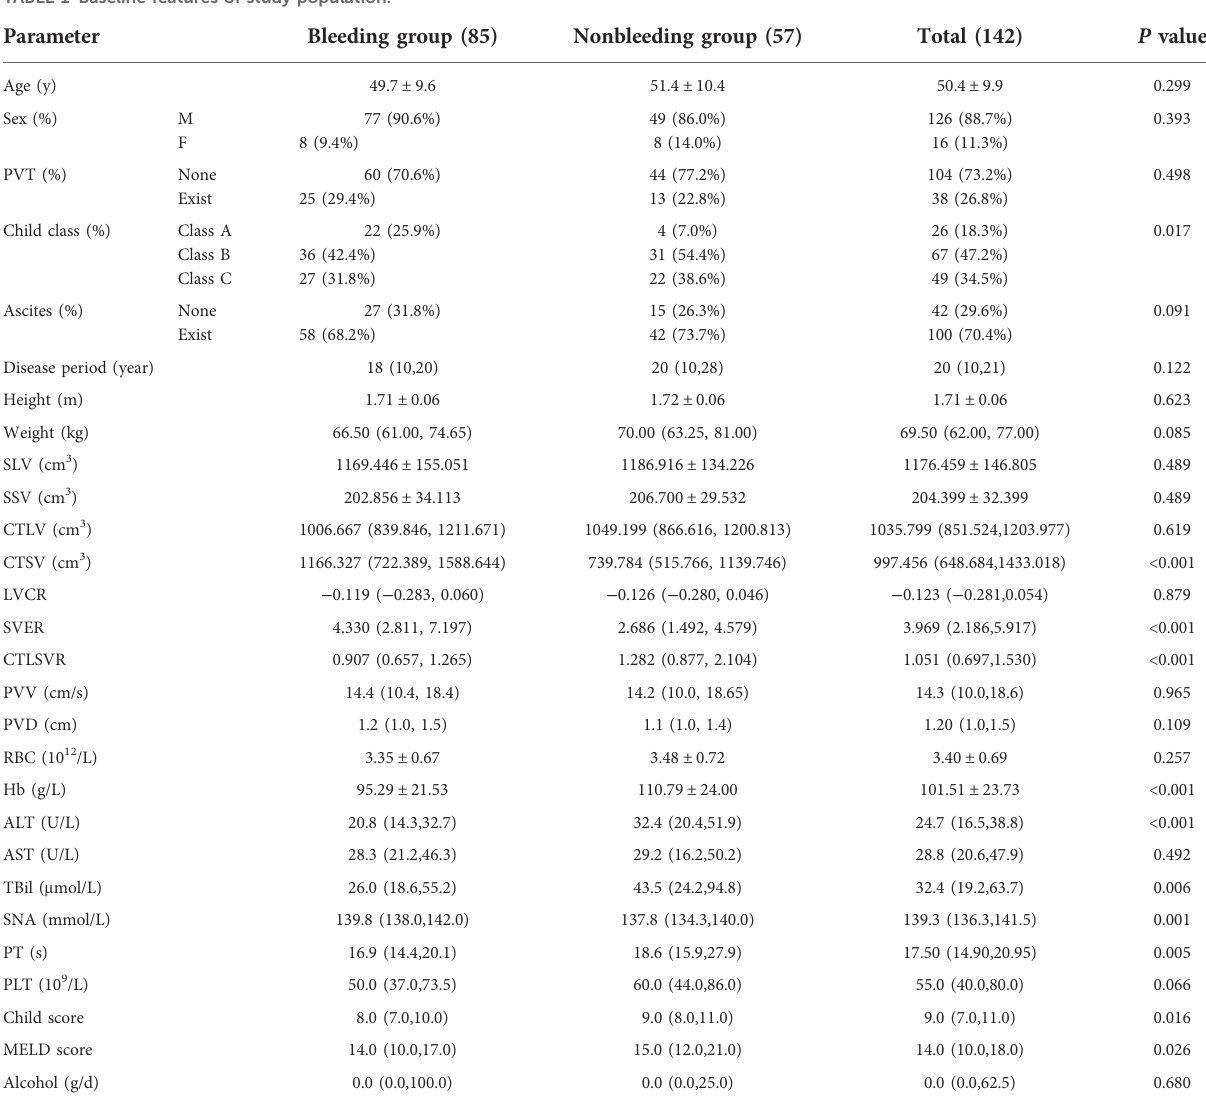
TABLE 1 Baseline features of study